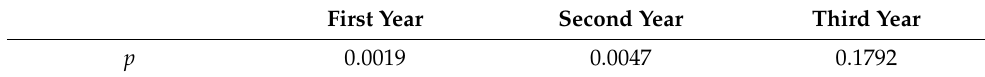
Table 2. Results of independent t -tests for each